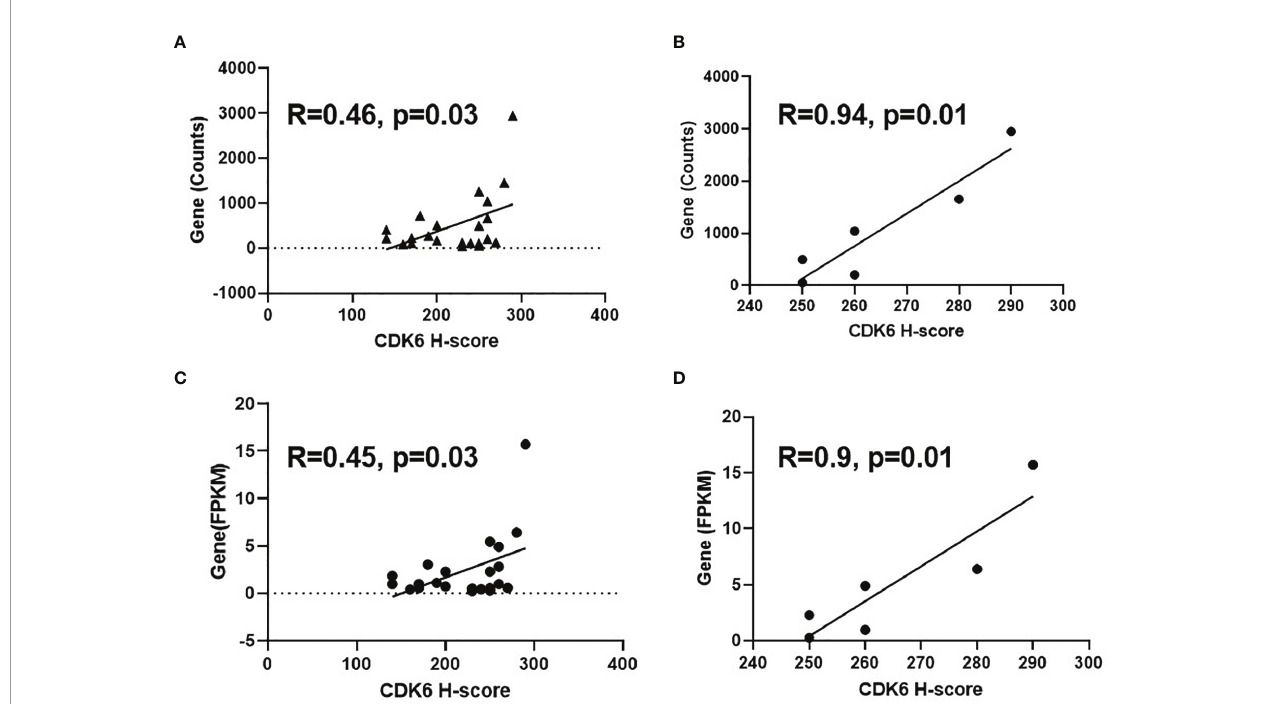
FIGURE 3 | Correlation between IHC score and mRNA level of CDK6 expression. Moderate correlation was observed [R=0.46, p =0.03 by H-score vs gene counts, (A) ; R=0.45, p =0.03 by H-score vs FPKM value, (C) ] for the comparison of H-score and mRNA level of 22 cases. Strong correlation was shown between IHC and RNA-sequencing methods [R=0.94, p =0.01 by IHC scores vs gene counts, (B) ; R=0.9, p =0.01 by IHC scores vs FPKM value, (D) ] after narrowing to the cases with CDK6 scores higher than